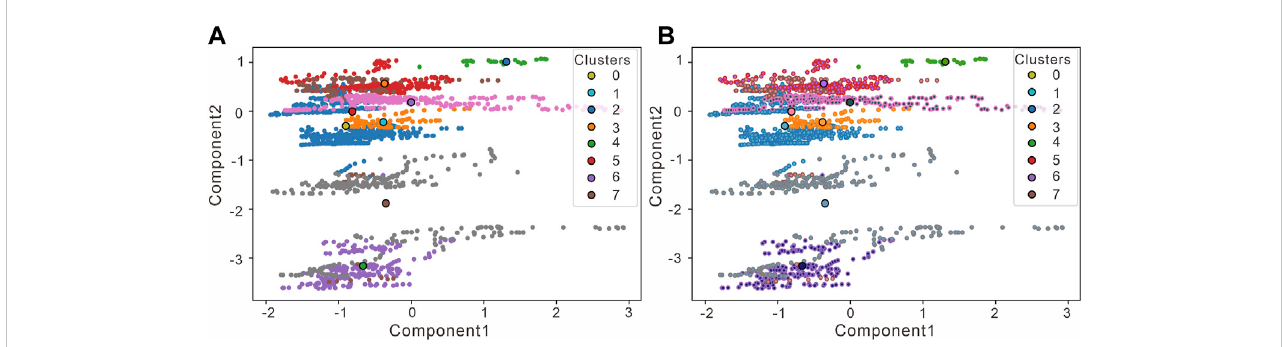
FIGURE 6 Theclusteringstepisperformedontheinputdata(PCAtransformed). (A) Thedistancesumofsquares( inertia )fromthesampletothenearestneighboris 6319.79whensetting K =8,andthenumberofiterationsis12. (B) Thedistancesumofsquaresfromthesampletothenearestneighboris891.84whensetting K = 56, and the number of iterations is 8.